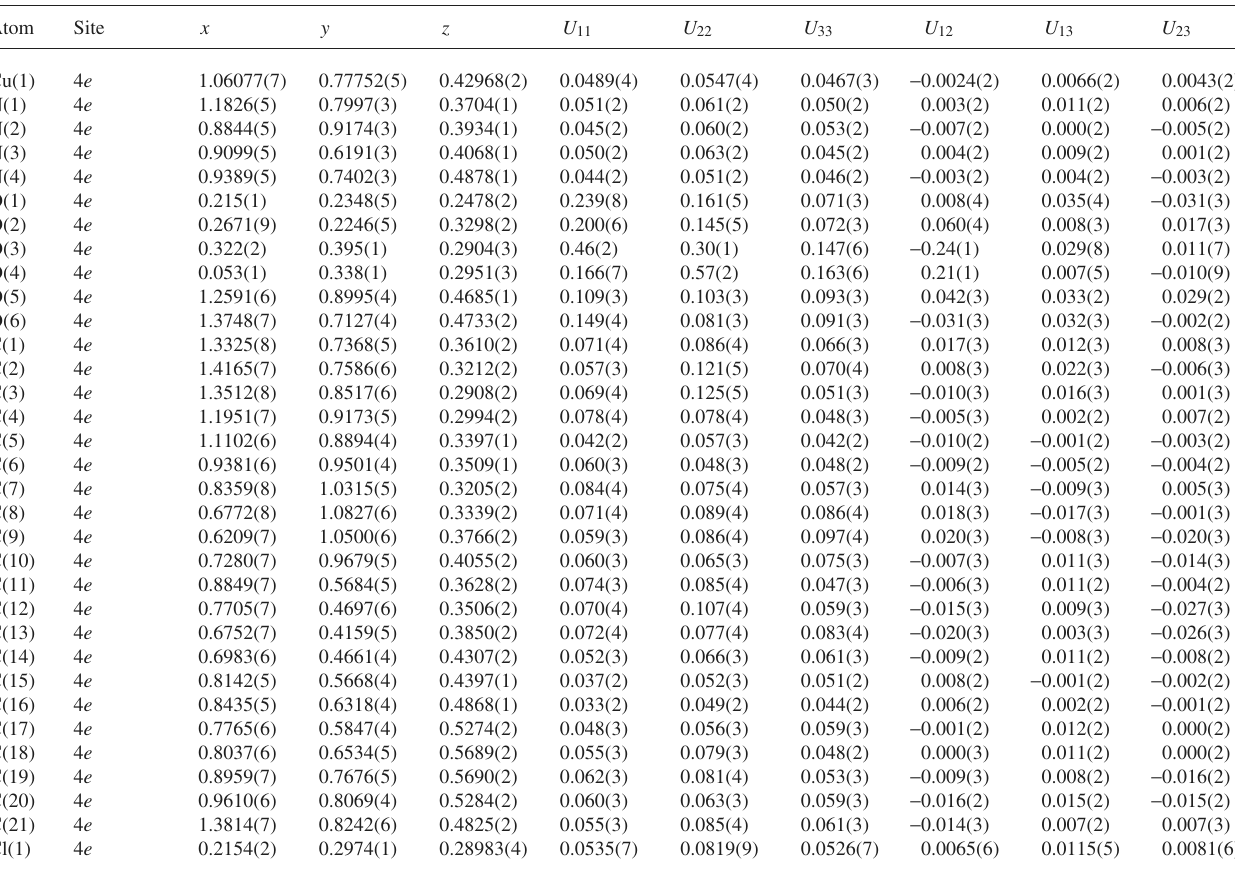
Table 3. Atomic coordinates and displacement parameters (in Å 2 )